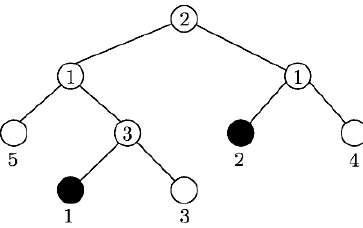
Figure 1. Binary tree representing u = ( x 5 ◦ 1 ( x 1 ◦ 3 x 3 )) ◦ 2 ( x 2 ◦ 1 x 4 ) with H = { 1 , 2 } . Emphasized leaves are colored in black, others  in white.